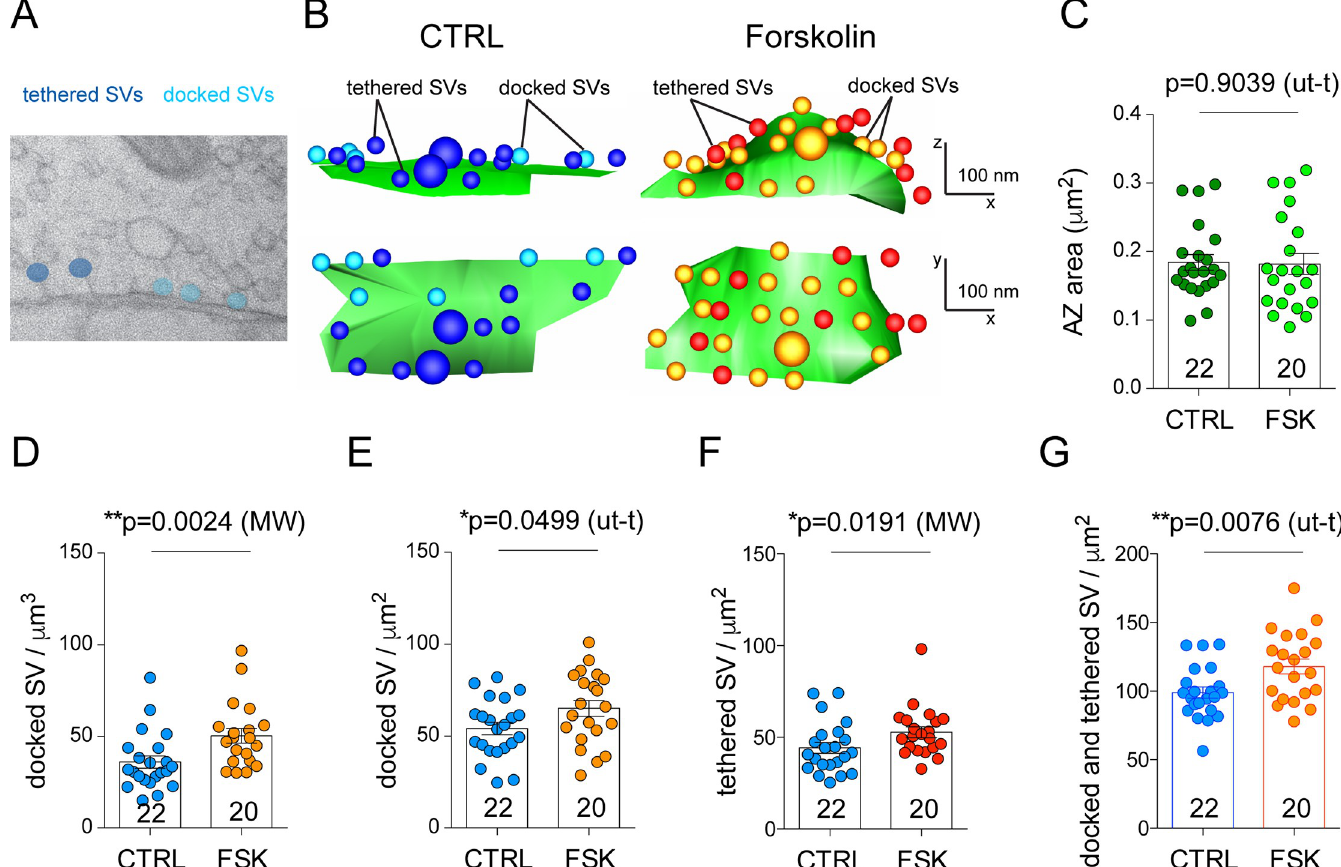
Fig 6. Docked vesicle density increases upon forskolin-induced potentiation. (A) Two-dimensional electron microscopy image from a high-pressure frozen mossy fiber AZ showing docked (light blue) and tethered (blue) SVs. (B) Three-dimensional reconstruction of mossy fiber AZs from acute slices cryo-fixed in control conditions or after forskolin treatment. Top panels show the xz views, and bottom panels the xy views. (C) Bar graph indicating the quantification of AZ area ( μ m 2 ) for control and forskolin-treated boutons. (D–F) Bar graphs indicating the quantification of docked vesicle density in the whole bouton (docked SV/ μ m 3 ) (D), docked vesicle density per square micron of AZ (docked SV/ μ m 2 ) (E), and tethered vesicle density per square micron of AZ (tethered SV/ μ m 2 ) (F) in control and forskolin- treated boutons. (G) Bar graph indicating the quantification of the putative readily releasable pool, measured as docked and tethered vesicle density per square micron of AZ (docked and tethered SV/ μ m 2 ) in control and forskolin-treated boutons. Scatter points indicate the mean value for each individual bouton from 4 animals. Values represent mean ± SEM. AZ, active zone; CTRL, control; FSK, forskolin; MW, Mann–Whitney U test; SV, synaptic vesicle; ut-t, unpaired t test. The data underlying this figure can be found at doi: 10.5281/zenodo.4498214.